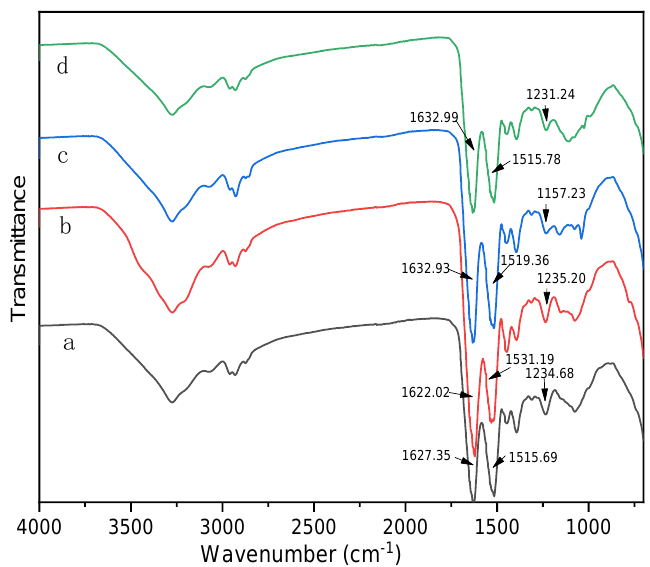
Figure 3. Attenuated total reflection (ATR)-FTIR spectroscopic results from the cured adhesive samples: ( a ) SPI adhesive, ( b ) SPI-Urea adhesive, ( c ) SPI- sodium dodecyl sulfate (SDS) adhesive, ( d ) SPI- sodium hydrogen sulfite (SHS) adhesive.